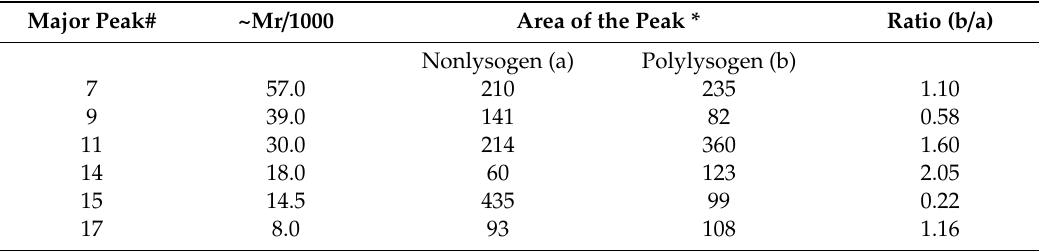
Table 5. Relative amounts of major outer membrane proteins of nonlysogen and polylysogen. 1.